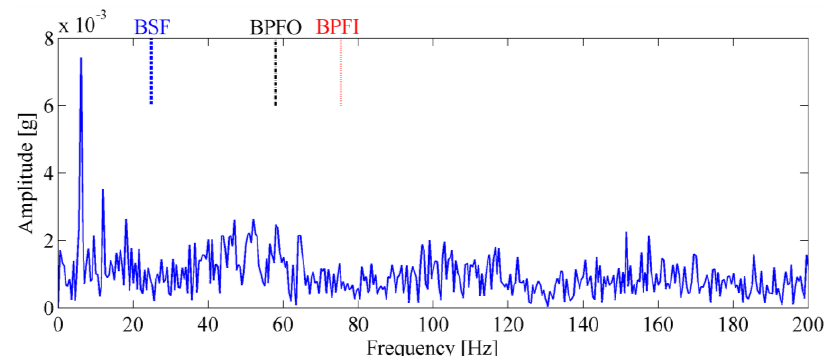
Figure 13. The envelope spectrum of the bearing